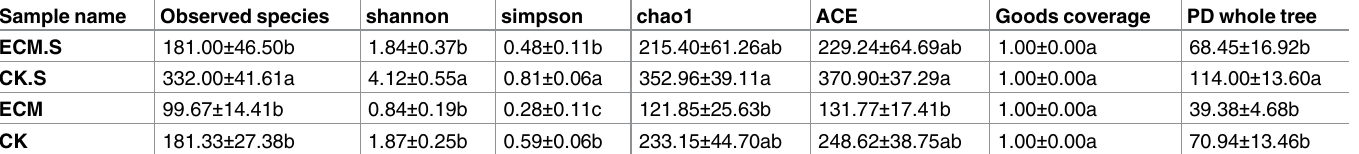
Table 2. Community richness and diversity indices of fungi associatedwith Pinus armandii roots and surrounding soils with or without Tuber indicum partner. Sample